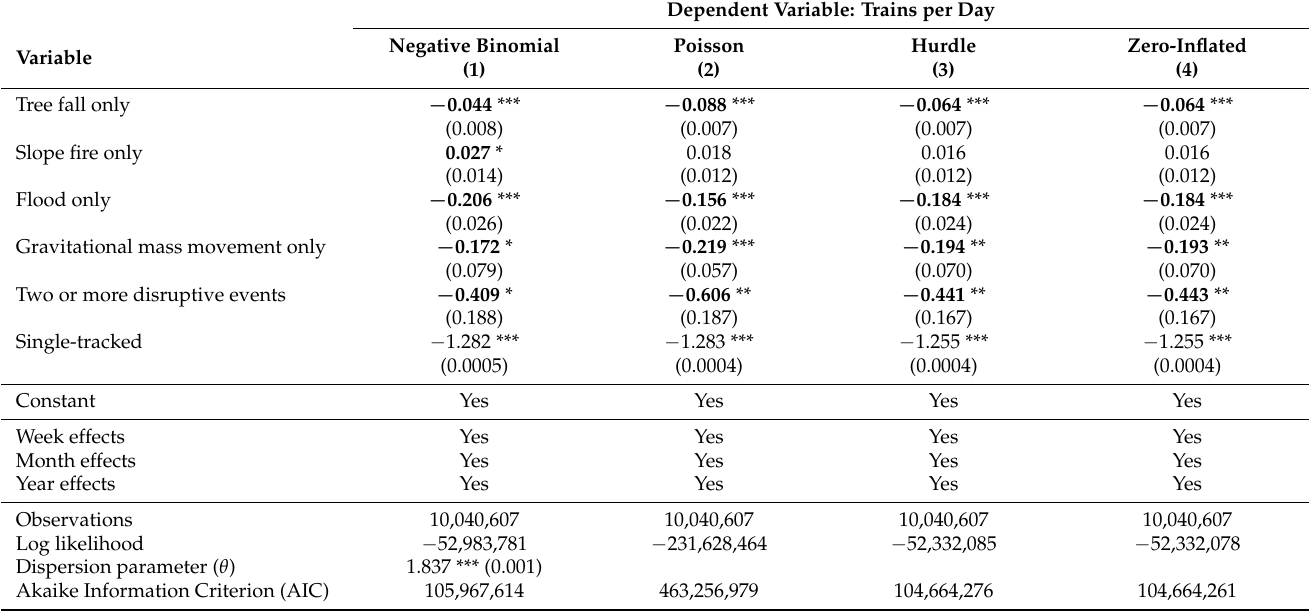
Table 4. Regression